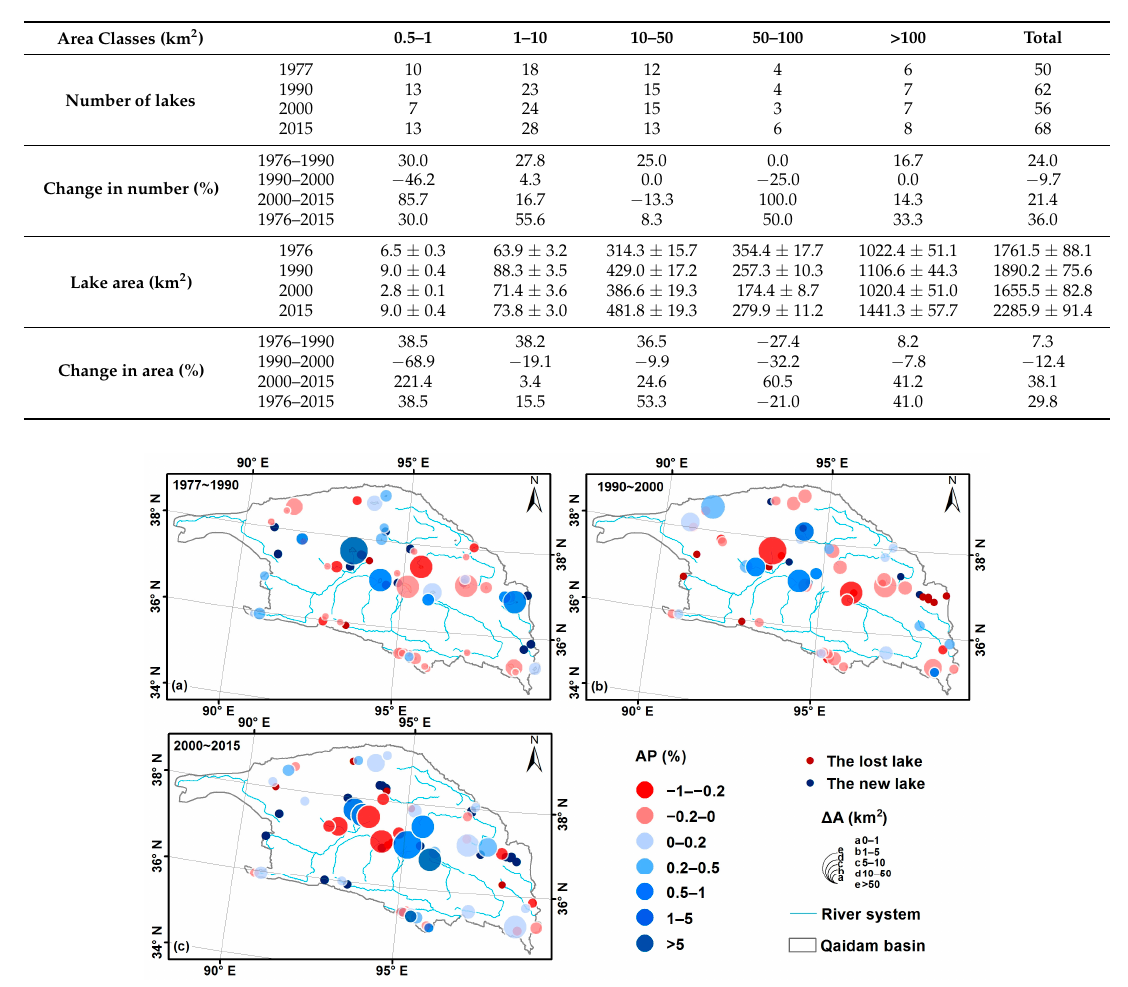
Table 4. The number, area, and changes of lakes in different sizes in the four stages between 1977 and 2015.